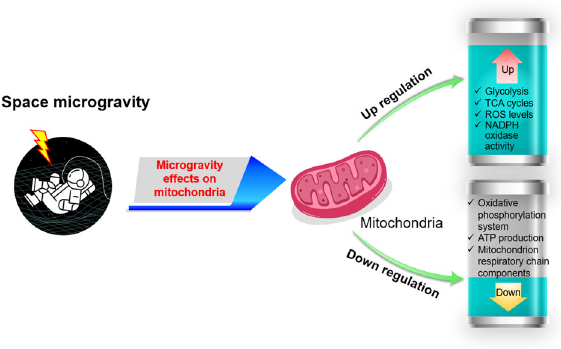
Fig. 1 Space microgravity and biological functions of mitochondria. Space microgravity induces the upregulation of glycolysis, TCA cycles, ROS levels, and NADPH oxidase activity in mitochondria. On the other hand, oxidative phosphorylation, ATP production, mitochondrion respiratory chain components are downregulated. (Copyright of spaceman icon was purchased from The Noun Project, Inc. CA,